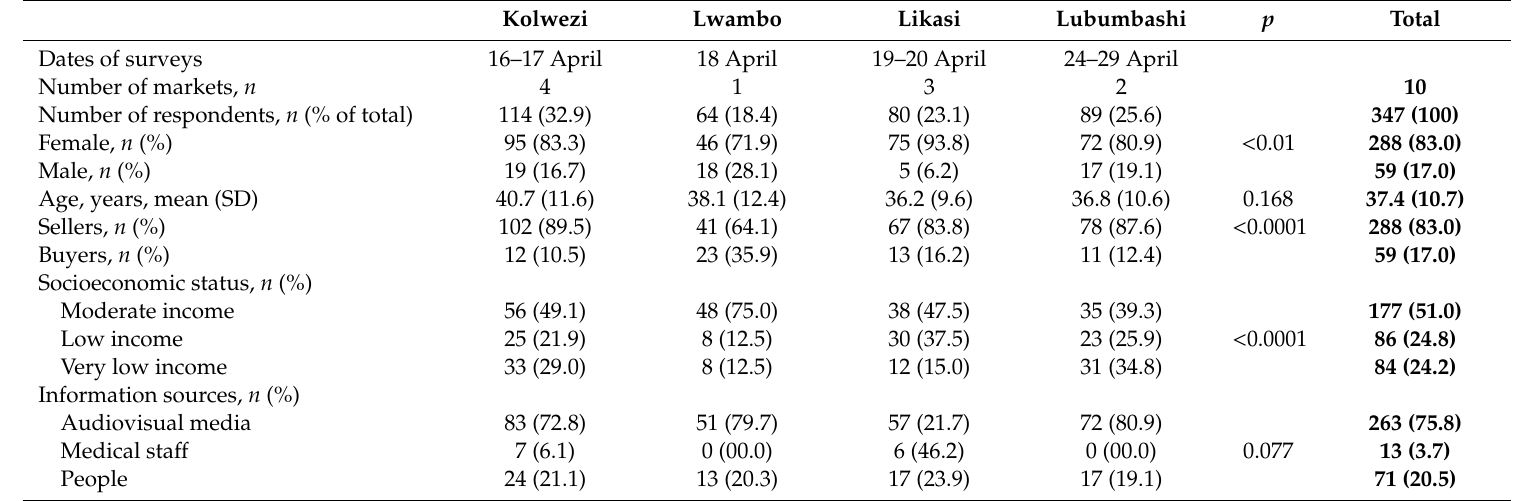
Data are numbers with percentages. Data in bold (last column) concern the total participants. Socioeconomic status (SES) was based on the reported main source of information received on COVID-19: participants who declared having obtained information from watching their own televisions or through the internet (smartphone) were classified as having a moderate income; participants who obtained information from their radio were considered as having a low income; participants who did not mention these sources of information and / or received information only from “other people” were considered as having a very low income. DR: Democratic